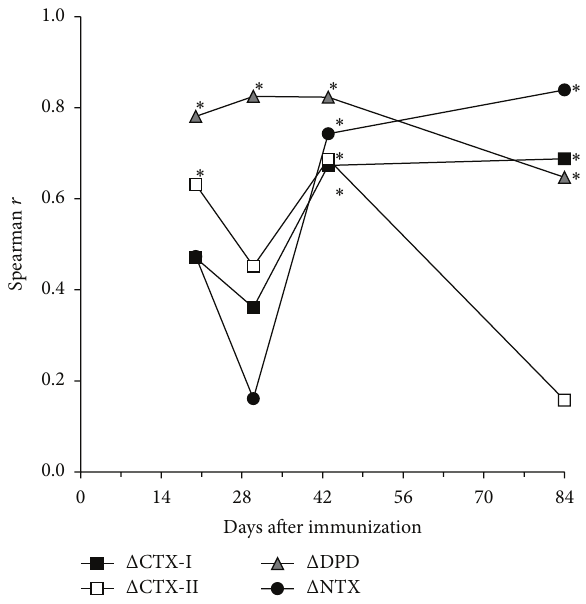
Figure 2: Association between joint swelling score and increases in urinary CTX-II/Cr, CTX-I/Cr, NTX/Cr, and DPD/Cr at each time point. ∗ 𝑃 < 0.05 (Spearmanrankcorrelation).CTX-I,C-telopeptide fragment of type I collagen; CTX-II, C-telopeptide fragment of type II collagen; DPD, deoxypyridinoline; NTX, N-telopeptide fragment of type I collagen; Cr,